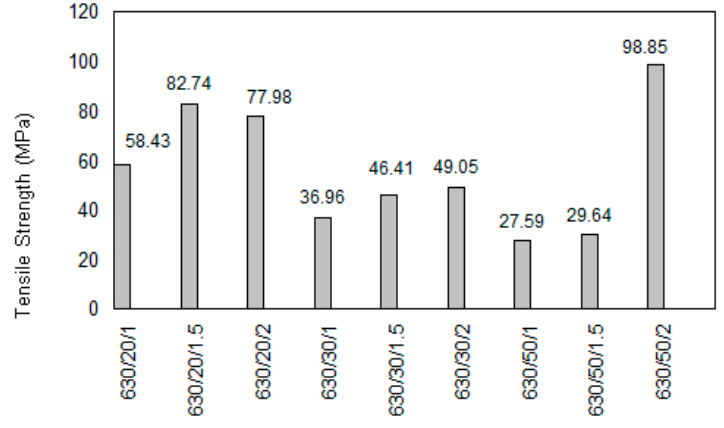
Figure 6. Tensile test results of 630 rpm.